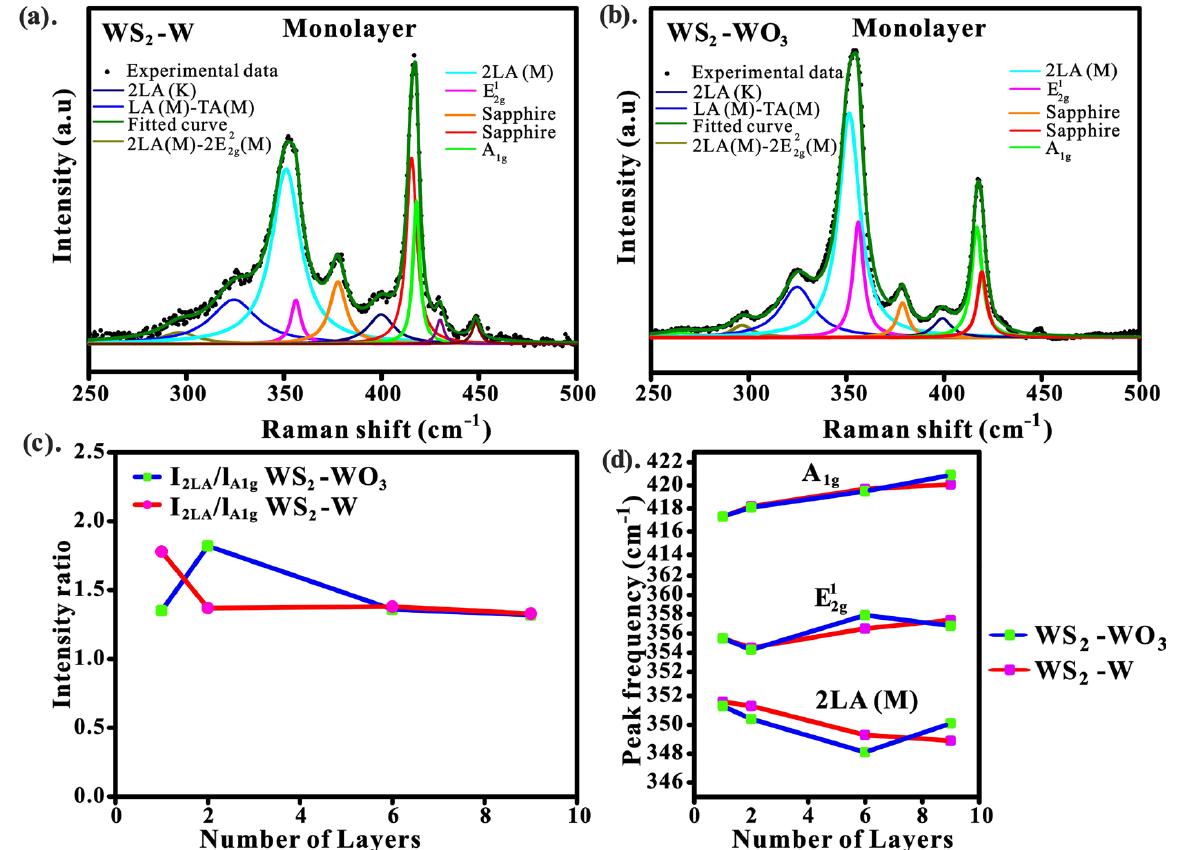
Figure 6. ( a , b ). Deconvolution of the Raman spectra of WS 2 - W and WS 2 - WO 3 , respectively, using Lorentz fitting method; ( c ) the intensity ratio of I 2 LA / I A as a function of the number layers of WS 2 ; ( d ) the peak positions of A 1g , E 1 , and 2LA with respect to the number layer of WS 2 . Additionally, the deconvolution of the Raman spectra for bilayer, six-layer, nine-layer can be seen in the Supplementary